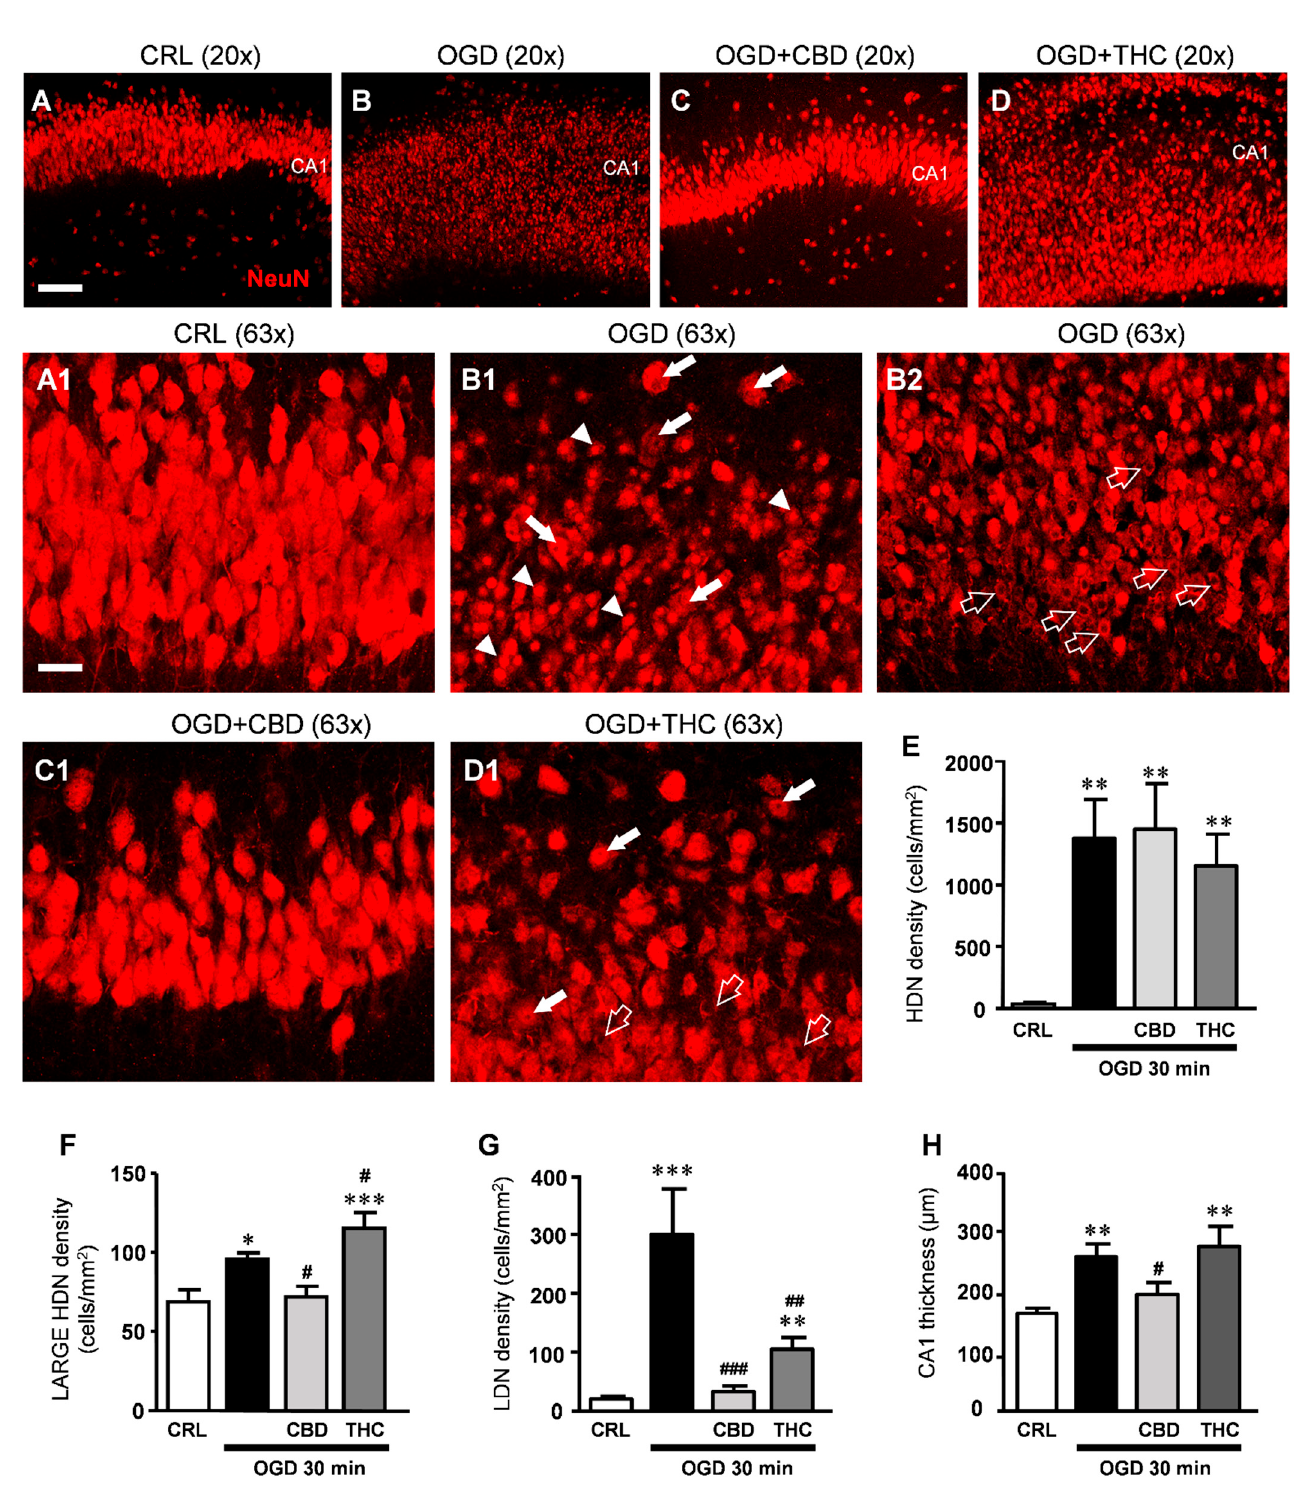
Figure 5. ( A – D ) Representative confocal images of neurons immunostained using antibodies against NeuN in CA1 of a CRL ( A ), OGD ( B ), OGD + CBD ( C ), and OGD + THC slice ( D ) captured with a 20x objective, scale bar: 75 µm. ( A1 – D1 ) Confocal images obtained stacking 10 consecutive z-scans acquired in the depth of the corresponding slice shown in ( A , B , C , D ), respectively (0.3 µm each, total thickness 3 µm), captured with a 63x objective. A1: Image taken from the control slice in A showing healthy pyramidal neurons in CA1. ( B1 , B2 ): Both images of CA1 were taken from the OGD slice in ( B ) and show clearly that neurons are profoundly damaged after OGD. ( B1 ): HDN neurons (arrowheads), large HDN neurons (white arrows); ( B2 ): LDN neurons (open arrows). ( C1 ): The image of CA1 taken from the OGD + CBD slice in ( C ) shows